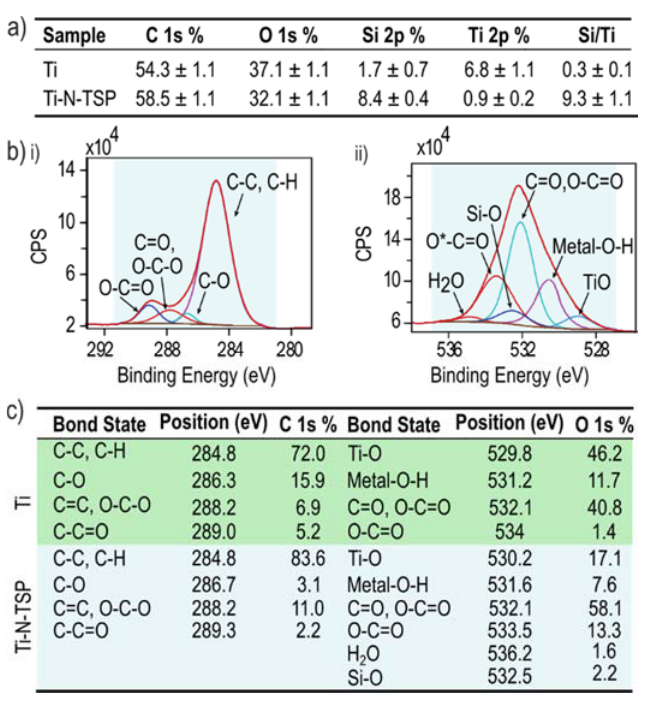
Figure 3. ( a ) Surface’s chemical composition (atomic percentage, %) and Si/Ti relative atomic ratio (mean ± standard deviation (SD)). ( b ) Deconvolution of high resolution spectra of (i) carbon and (ii) oxygen. ( c ) Peak position (eV) and relative intensities (percentages, %) of O 1s and C 1s signals for Ti and Ti–N–TSP samples (mean ± standard deviation (SD)).